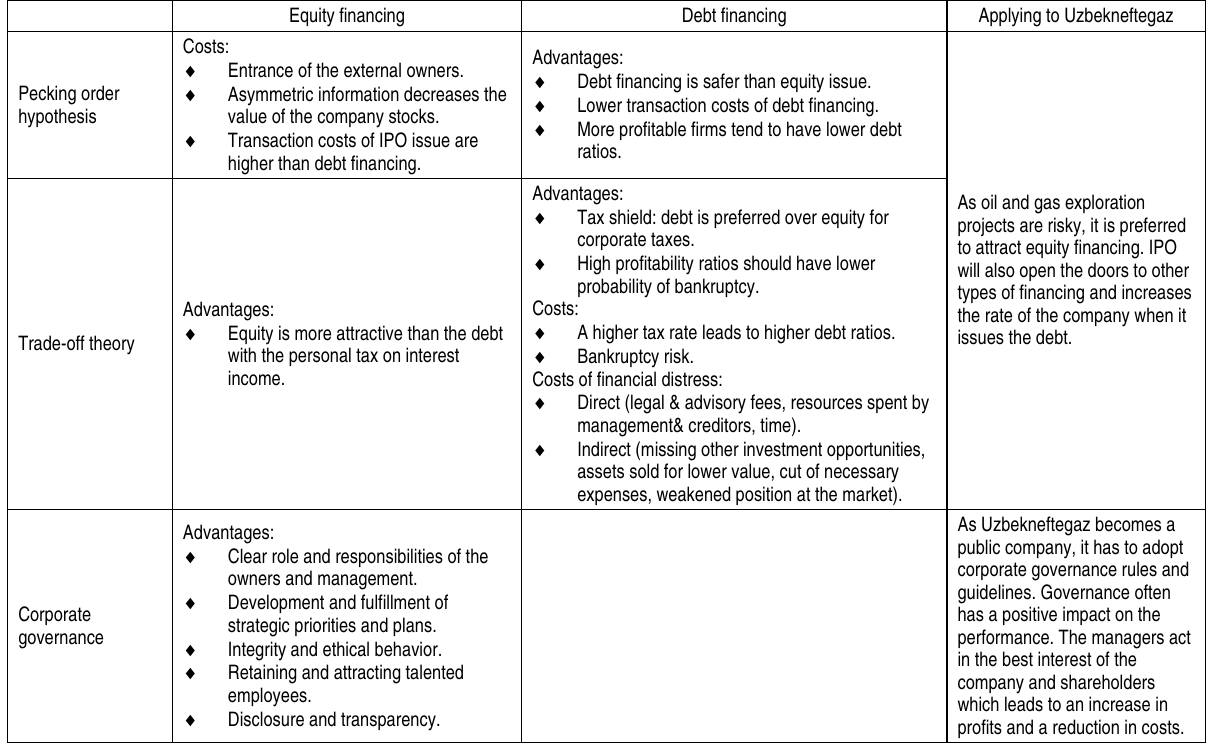
Table 2. Comparison of equity and debt financings by the capital structure theories and their application to Equity